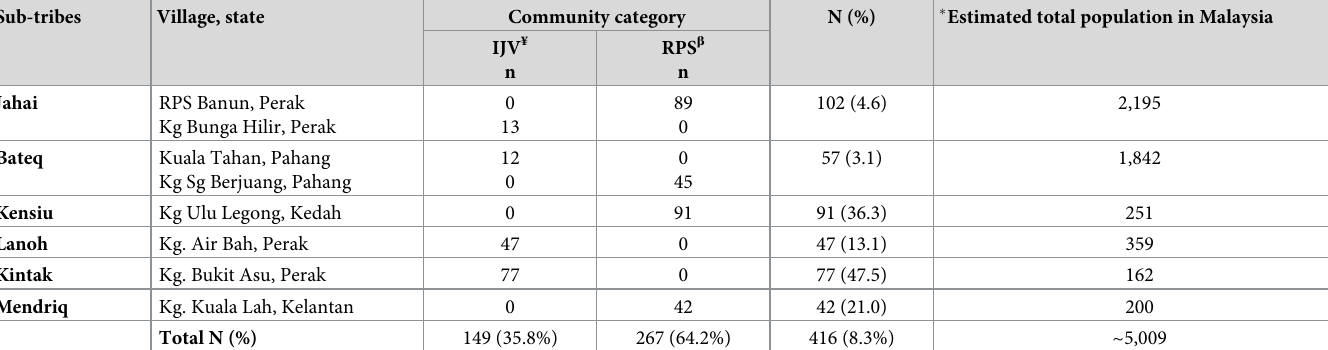
Table 1. Number of samples with the estimated number of Negritos based on their sub-tribes and community categories in Malaysia. Sub-tribes Village,